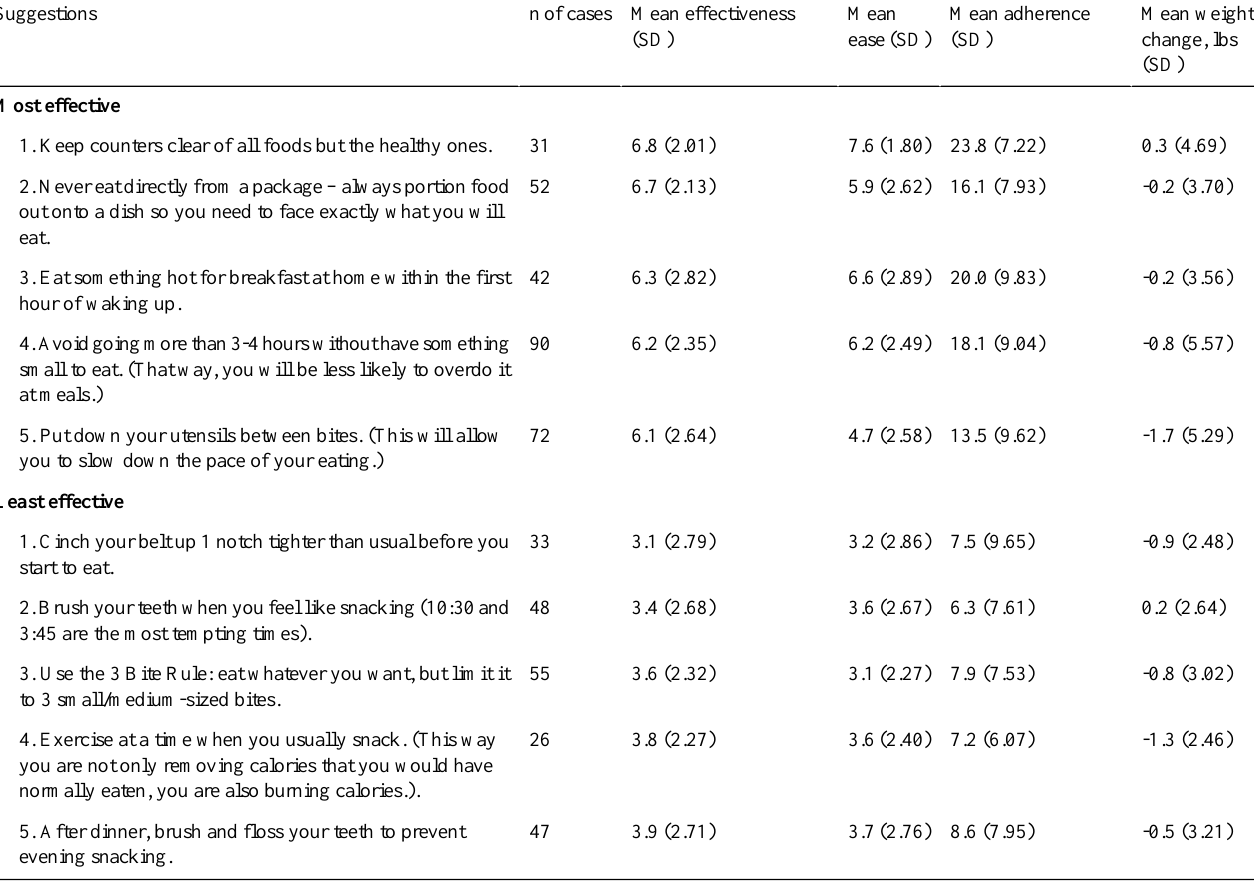
Table 4. Most and least effective suggestions.